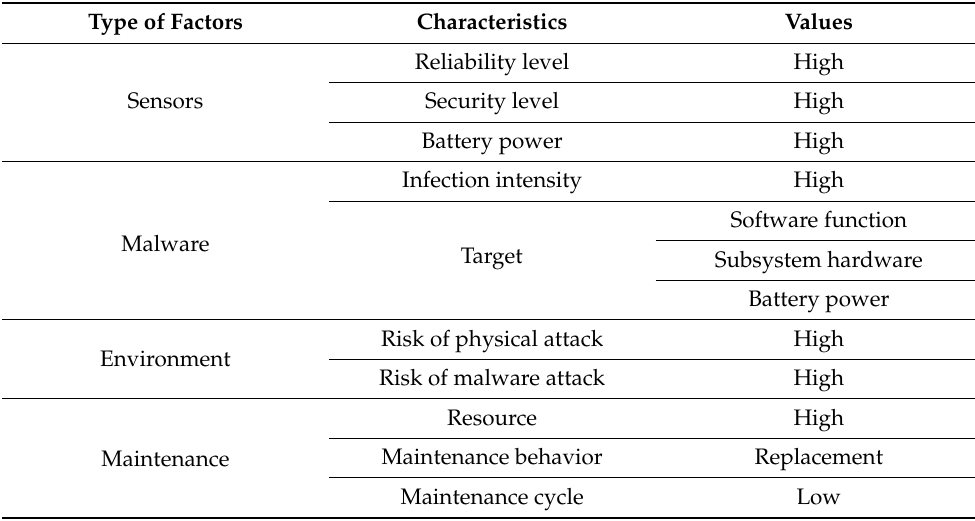
Table A1. Scenario 1 with characteristics and